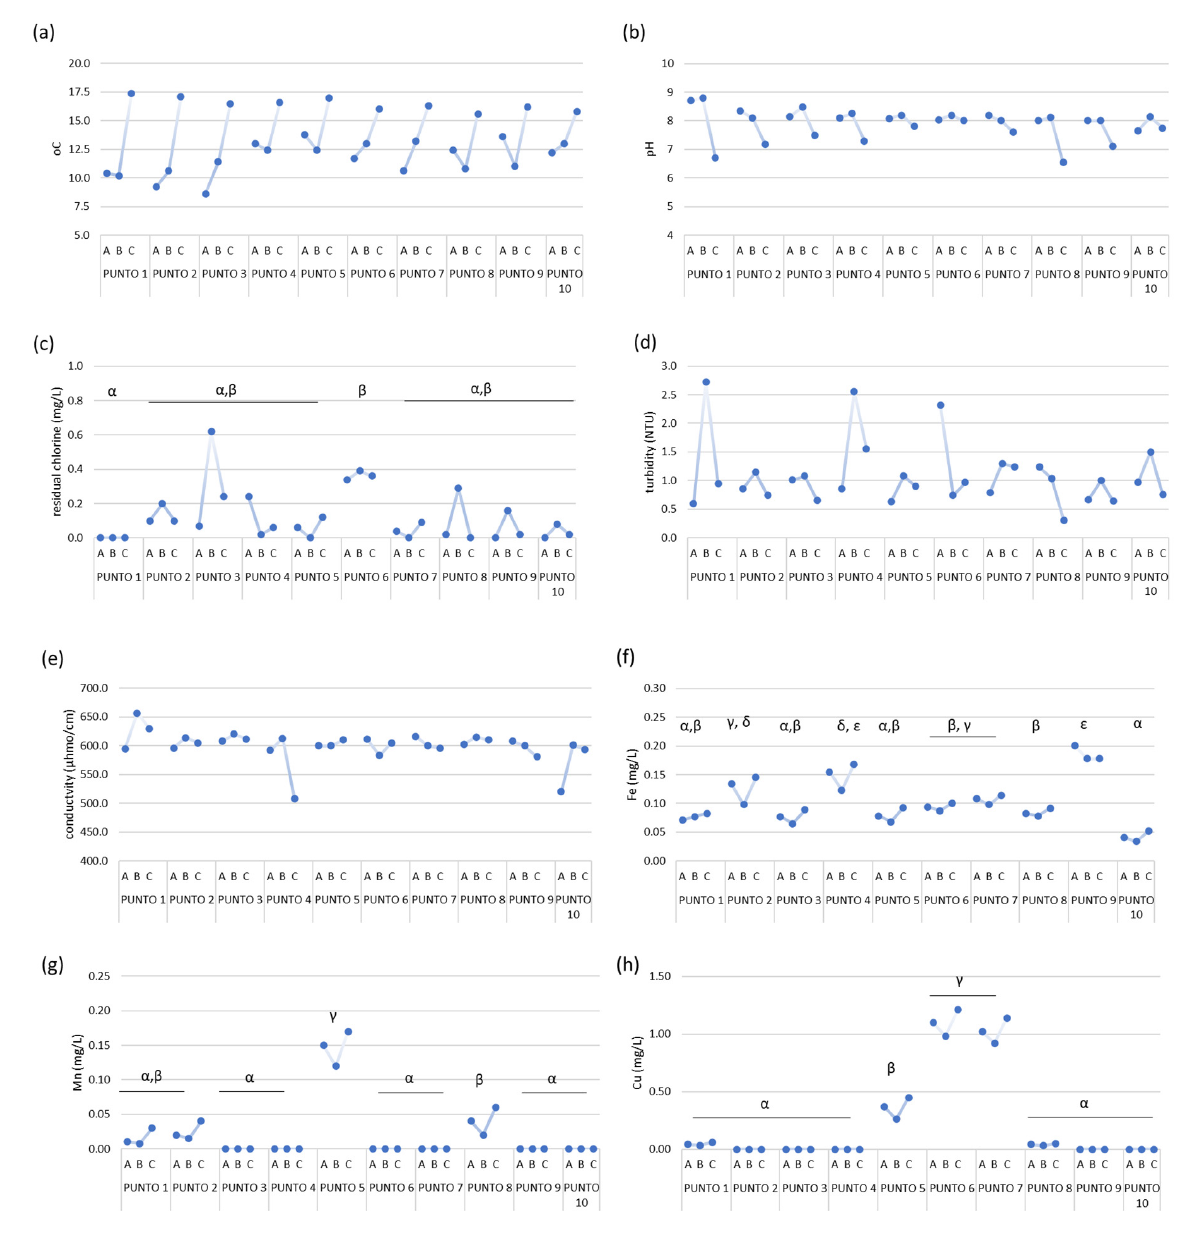
Figure 2. Determination of physical-chemical parameters for the 10 sampling points and three sampling dates: ( a ) temperature, ( b ) pH, ( c ) chlorine concentration, ( d ) turbidity, ( e ) conductivity, and the heavy metals concentration of ( f ) Fe, ( g ) Mn, and ( h ) Cu. Zn was not detected in the samples and Ni was only detected in samples A from Punto 2 and 3, at 0.001 and 0.003 mg/L, respectively. When observed, significant differences ( p < 0.05) between samples are indicated by the letters α , β , γ , ε , and δ .